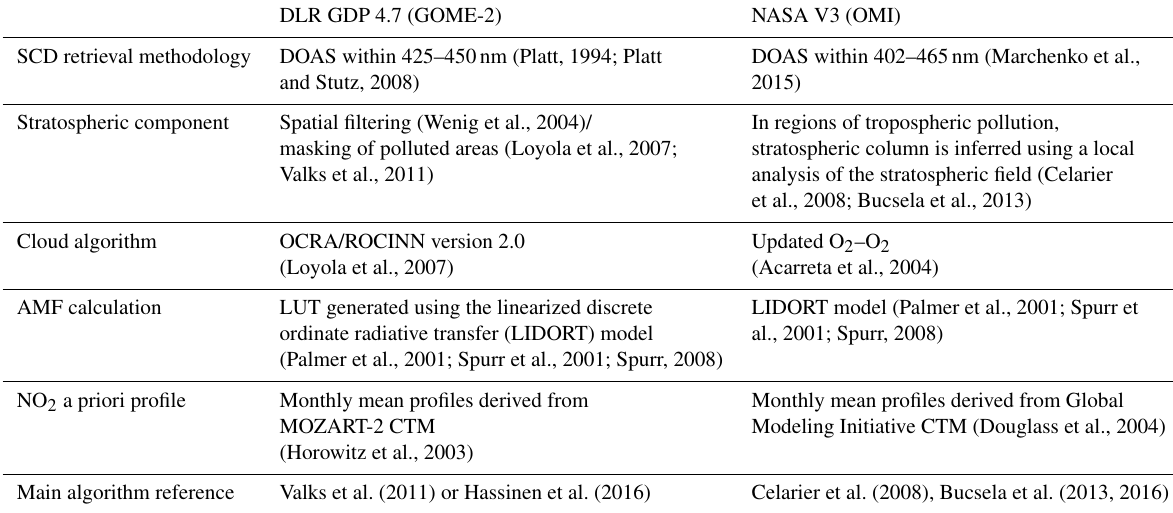
Table 3. Main features of the satellite